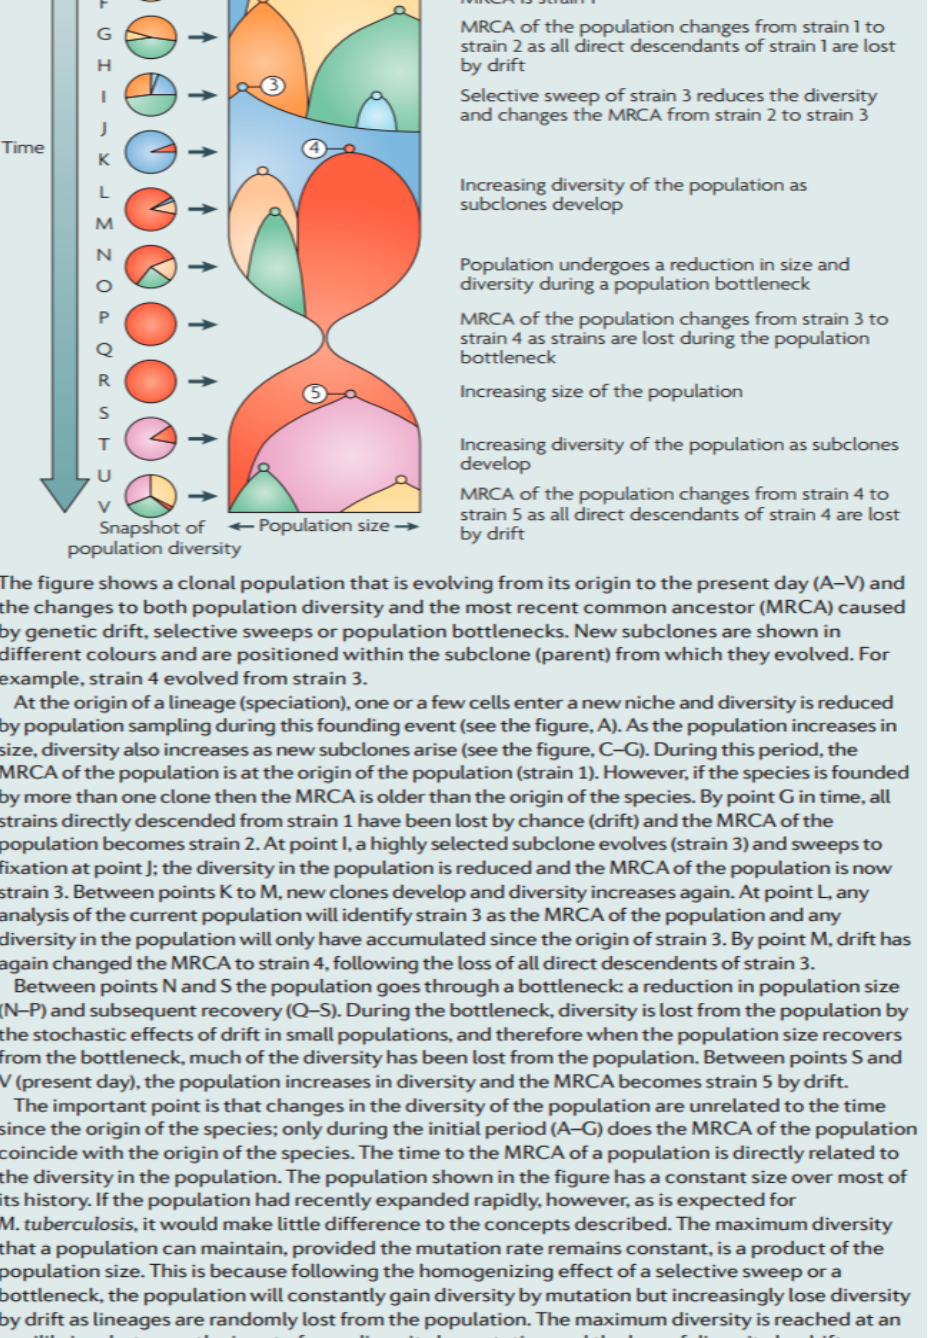
Figure 10. An objective general overview of most recent common ancestors (MRCAs) [107].